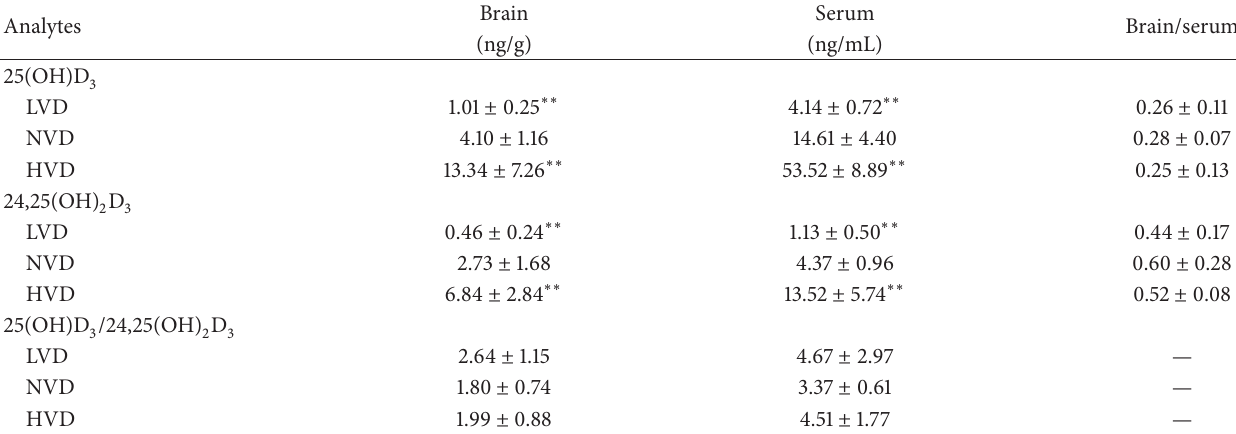
Table 4: The levels of targeted analytes and ratio of 25(OH)D 3 /24,25(OH) 2 D 3 in brain homogenates and serum.